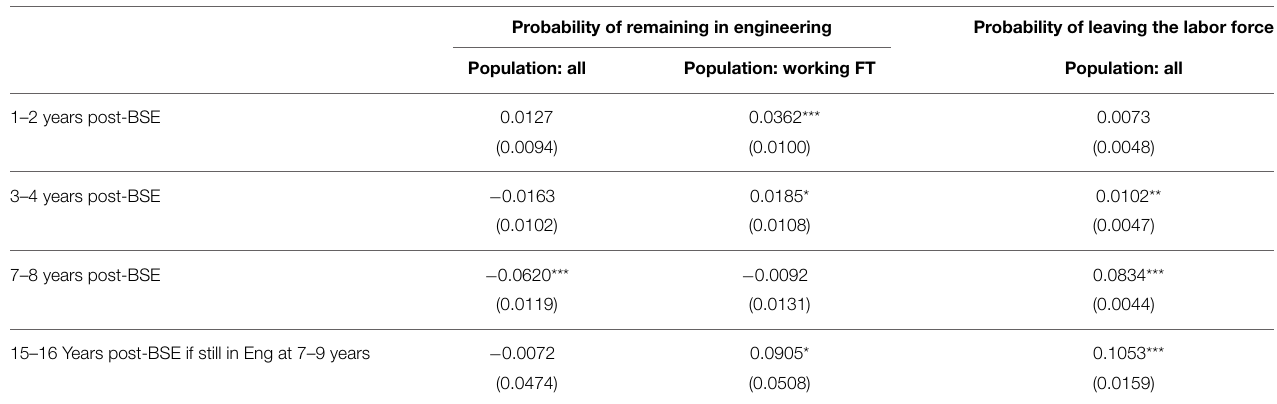
TABLE 2 | Coefficient on female from linear probability models of remaining in engineering: all cohorts combined. Probability of remaining in engineering Probability of leaving the labor